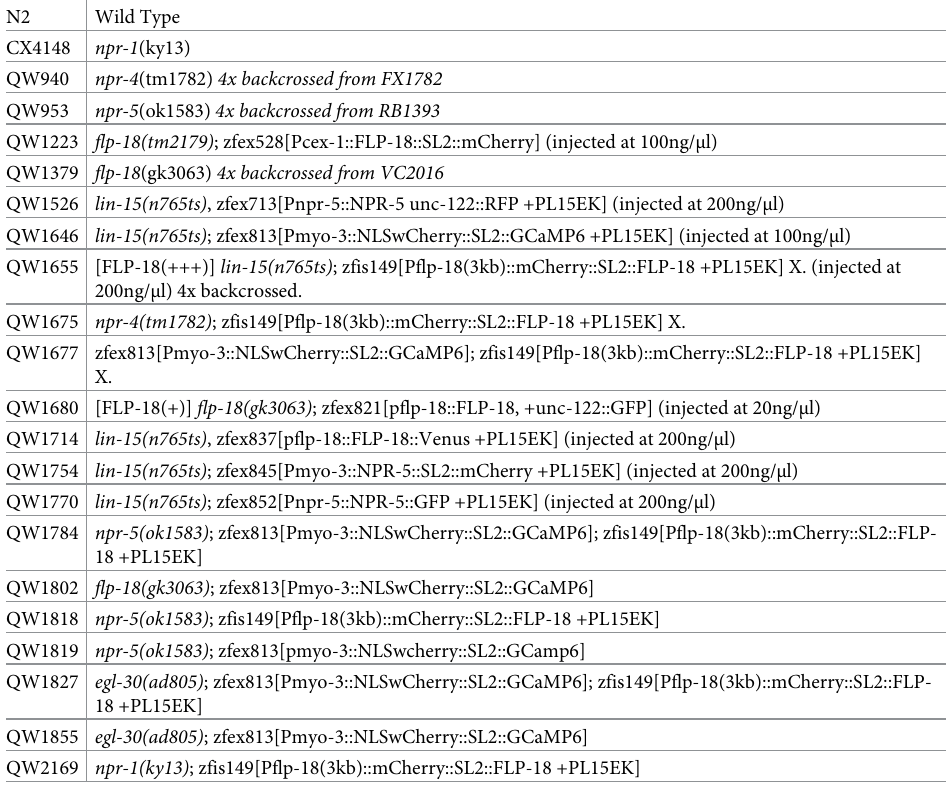
DNA into lin-15(n765ts) . A lin-15 rescuing plasmid (PL15EK) was used as a co-injection marker (80 ng/ μ l) and transgenics were identified based on rescue of the lin-15 multivulva phenotype. FLP-18 transgenic strains were created by amplifying a 5.9kb sequence of genomic DNA beginning 3.3kb upstream of the open reading frame and containing the flp-18 coding region as well as the 3’ UTR. The sequence was amplified using the forward primer 5’-GTG ATGTAGGTAGCGCGGAAC-3’ and 5’-TTCATGATCCCAGATTCAATTAATC-3’ reverse primer. This amplicon was ligated into a plasmid containing an SL2 linked mCherry transcrip- tional reporter to visualize expression. This plasmid was injected along with pL15EK and transgenics were identified based on lin-15 rescue. The extrachromosomal array was stably integrated into the genome using X-ray irradiation and were backcrossed to wild type N2 ani- mals 4 times. NPR-5 transgenics were created using Gibson Assembly (Gibson Assembly Mas- ter Mix (E2611), New England BioLabs inc., [79]) to insert the npr-5 genomic locus into a pSP72 plasmid backbone. The insert consisted of a 7.7kb sequence of genomic DNA beginning 3kb upstream of the npr-5 open reading frame and including the npr-5 coding sequence and 3’ UTR. The sequence was amplified using 5’-cagatctgatatcatcgatGGCCCCGTGATTCTTGTC A-3’ as a forward primer and 5’-atccccgggtaccgagctcgaatTCTTGCTCGGTGTGCATTTTC - 3’ as a reverse primer. The lowercase letters indicate the homology arms that anneal to pSP72 sequence, and the uppercase letters anneal to the npr-5 genomic locus for amplification. pSP72 was linearized for insertion using EcoRI. The resulting plasmid was injected along with pL15EK and transgenics were identified based on lin-15 rescue.